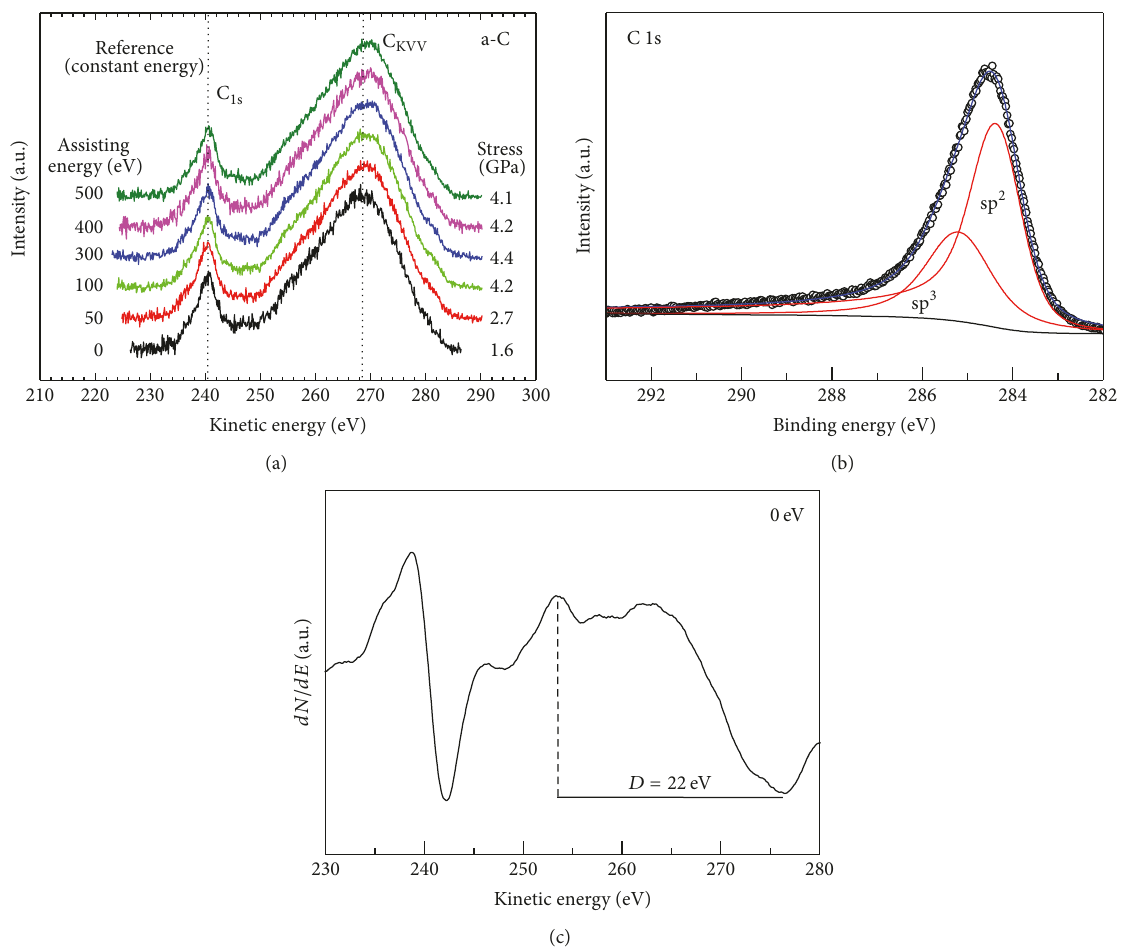
Figure 2: (a) XAES KVV spectra of carbon films. The background was subtracted out using the Shirley Model [16]. The very intense peak at approximately 240.5 eV is due to excitation of C 1s core by the K 𝛼 of O adsorbed on the anode of the X-ray tube and is used as reference. The vertical lines are only guide for the eyes used to emphasize the energy shift of the C KVV 1s centroid from the C 1s core level used as constant energy reference. (b) XPS spectra showing the binding energy of the C1s core level excited by the K 𝛼 of Al and the contributions of sp 2 and sp 3 hybrid states. (c) First derivative spectra of the XAES KVV showing the 𝐷 parameter estimated as 22